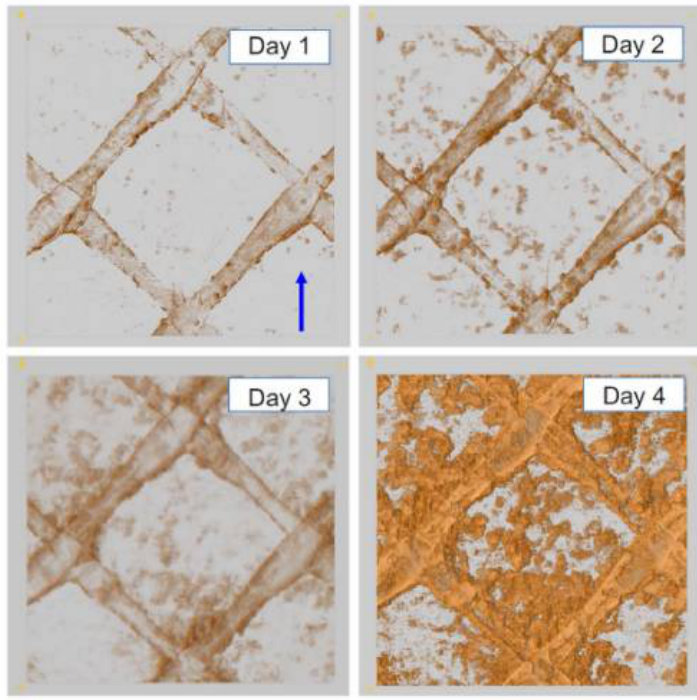
Figure 6. 3D rendering of OCT image and biomass (dark color) to show the development of a biofilm on a UF membrane (poly acrylonitrile (PAN)), 150 k Da) with 31 µ m feed spacer over time. The feed is tap water containing nutrient broth that is enriched to enhance biofilm formation. The MFS oper- ates at 1 bar with a lateral flow rate of 0.16 m/s, in the direction from bottom to top, as indicated by the arrow on the panel on day 1 [66].